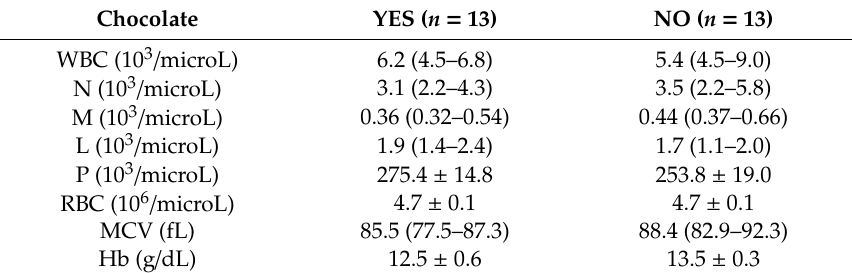
Table 2. Hematological parameters.